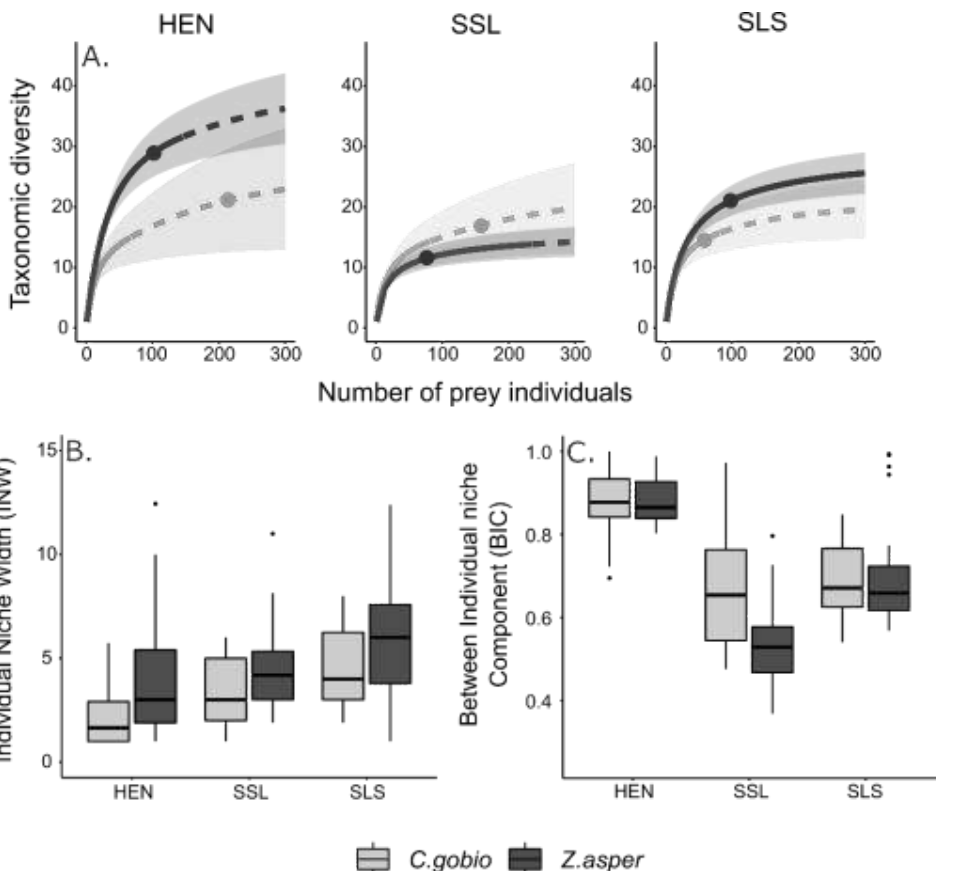
Figure 4. Trophic traits for Zingel asper and Cottus gobio . ( A ) Rarefaction curves of taxonomic diversity i.e., total niche widths (TNW), solid points; 85% sample coverage, solid lines; interpolated values, dashed lines; extrapolated values, shaded area; 95% confidence intervals. ( B ) Individual niche width (INW). ( C ) Between-individual component of the trophic niche (BIC). All trophic traits were calculated using Hill numbers ( 1 D).